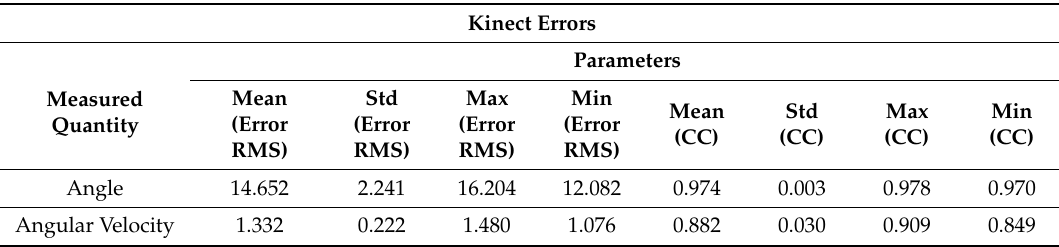
Table 4. RMS (Angle in ◦ , Angular Velocity in ◦ /s) and Correlation Coefficient (CC) between knee angles and angular velocities estimated using Kinect Vs universal